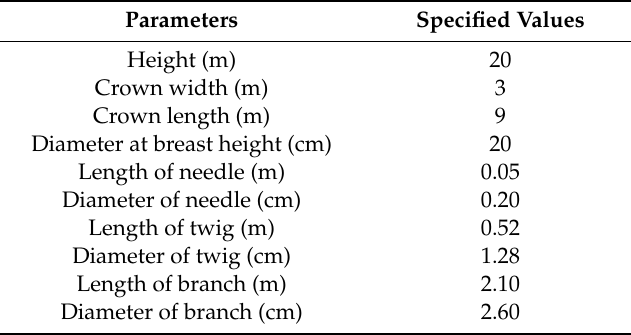
Table 8. Basic default forest parameters for sensitivity